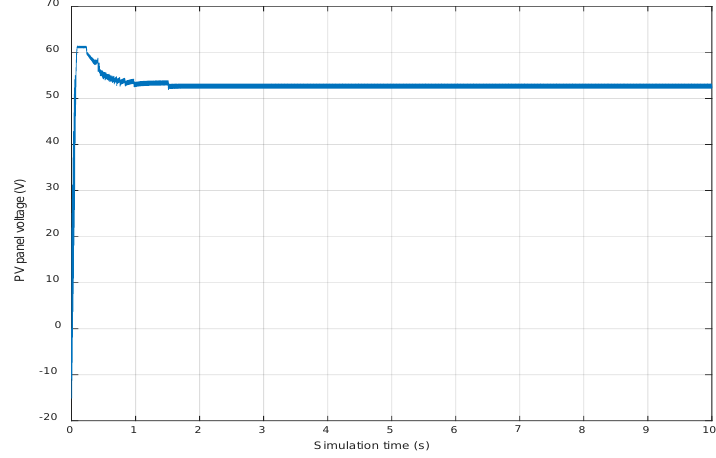
Figure 6. PV array output voltage at constant irradiation.